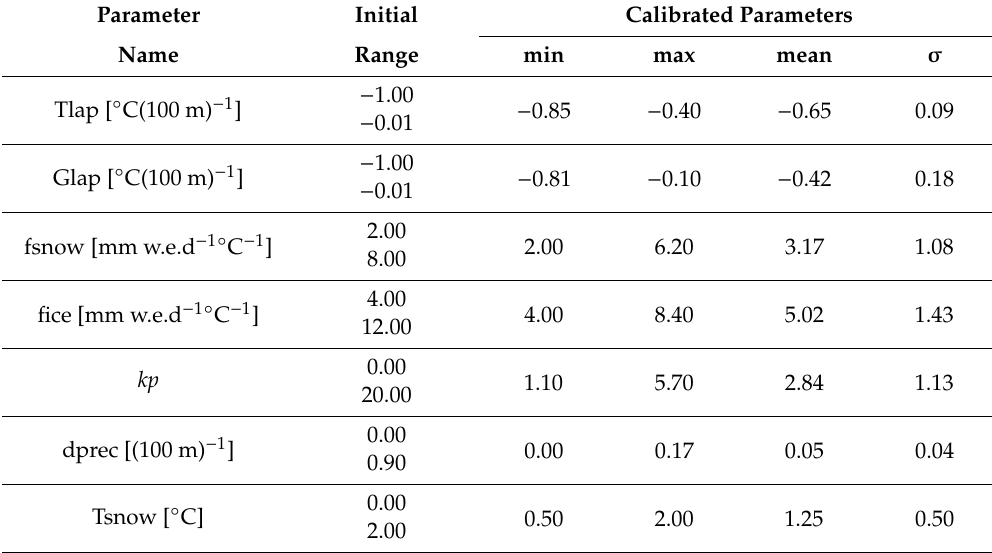
Table 1. Initial range of parameter values used in the model optimization and statistics for each optimized parameter: min, max, mean and standard deviation across the 45